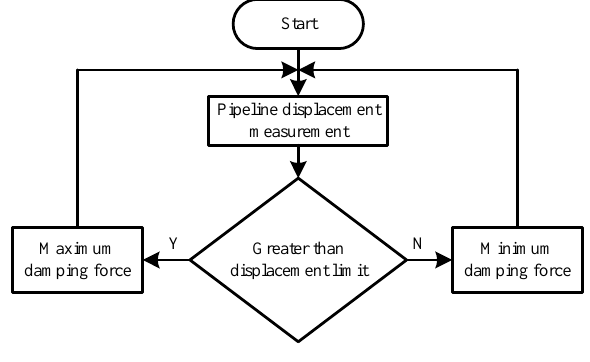
Figure 13. Two-state control diagram.